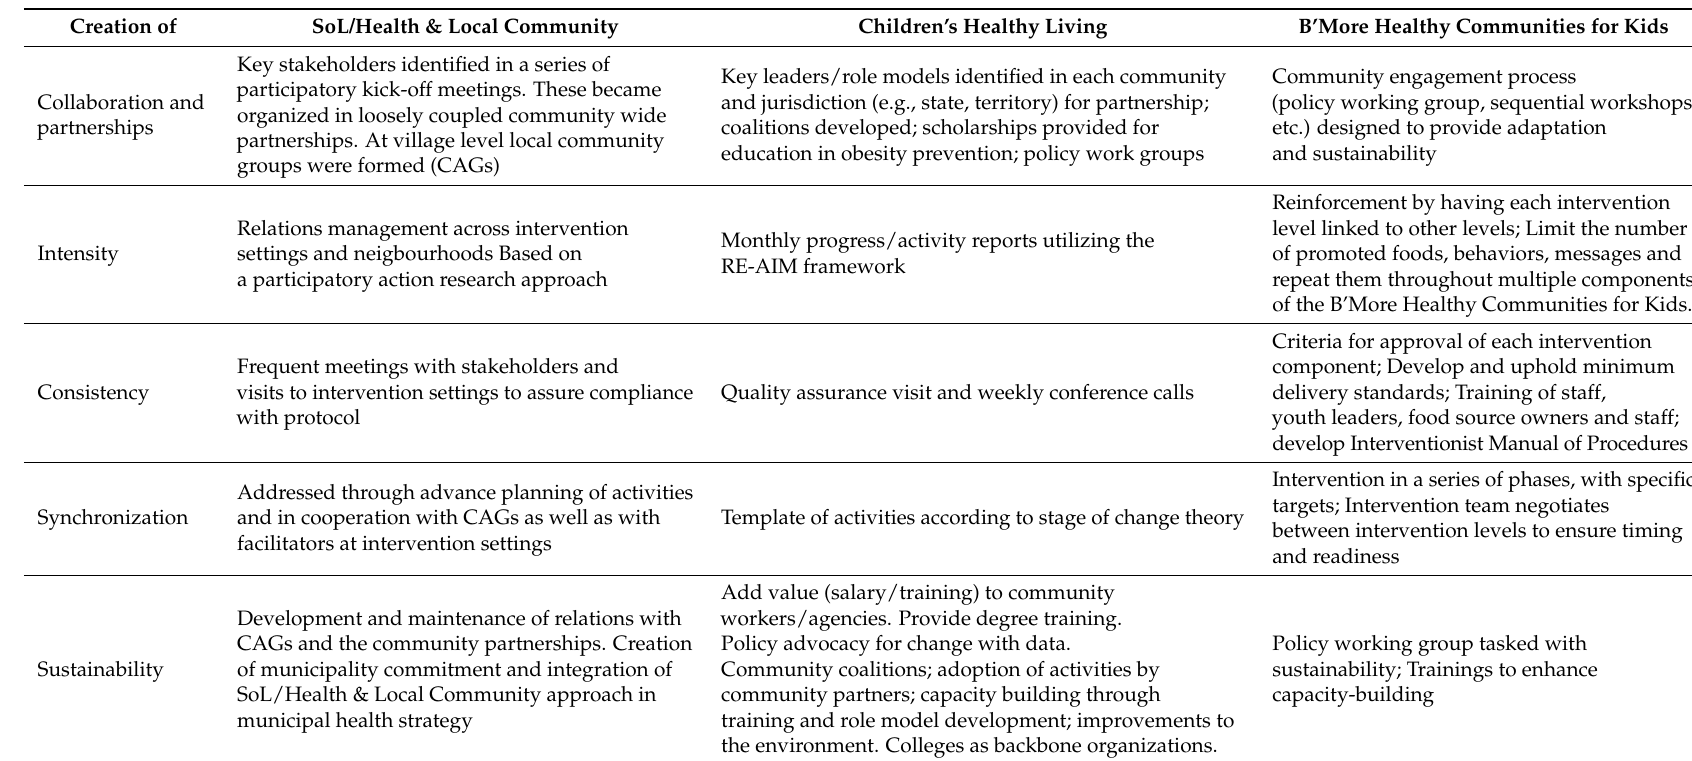
Table 4. Multilevel-Multicomponent (ML-MC) Toolkit. Approaches for meeting the challenges of ML-MC community-based intervention